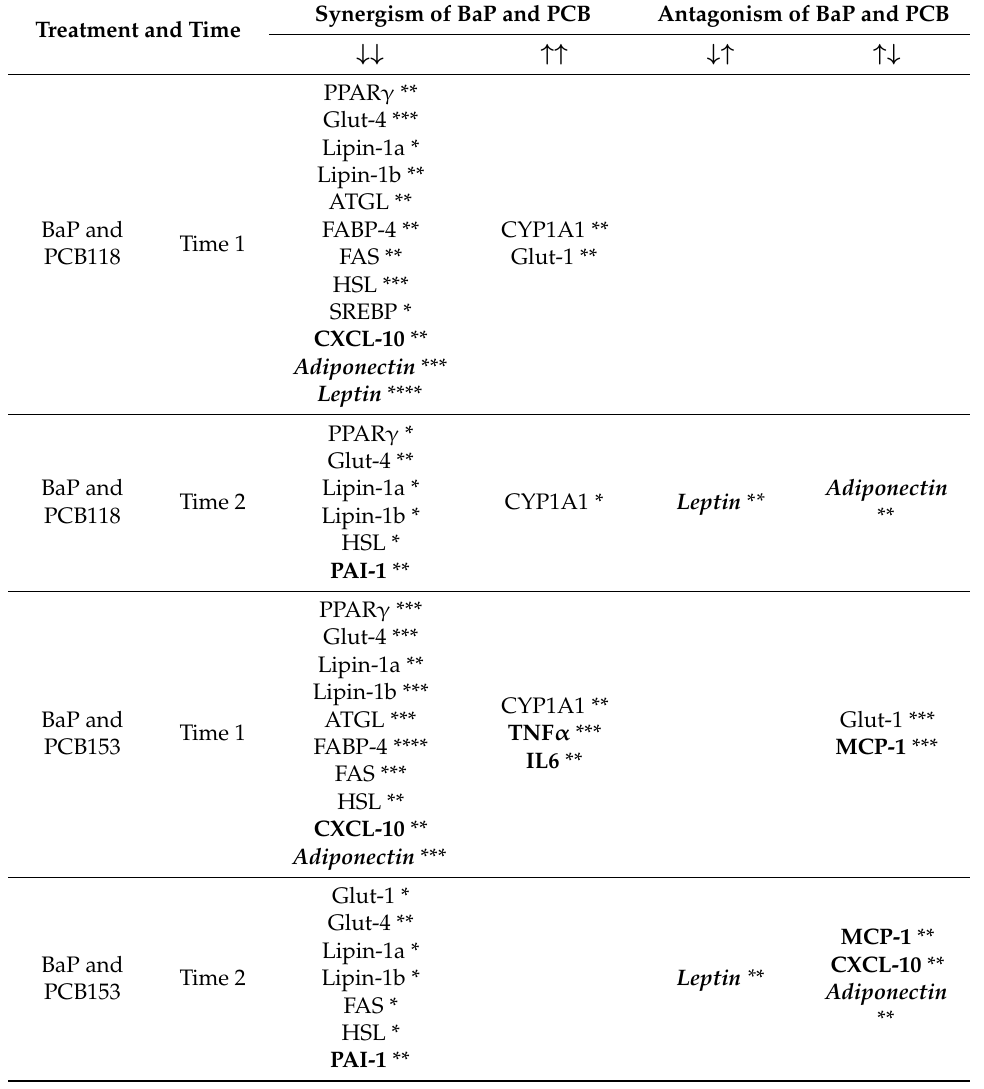
Table 1. Summary of synergic or antagonist cocktail effects of BaP and PCBs on genes expression in “Time 1” and “Time 2”: ↓↓ : down-regulation with BaP and down-regulation with PCBs. ↑↑ : up-regulation with BaP and up-regulation with PCBs. ↓↑ : down-regulation with BaP and up-regulation with PCBs. ↑↓ : up-regulation with BaP and down-regulation with PCB. Inflammatory genes are in bold characters. Adipokines are in italic and bold characters. The level of significance of differences between BaP-treated and PCB-treated assays is * p < 0.05; ** p < 0.01; *** p < 0.001. For details see the tables of significances (Table A1 in Appendix